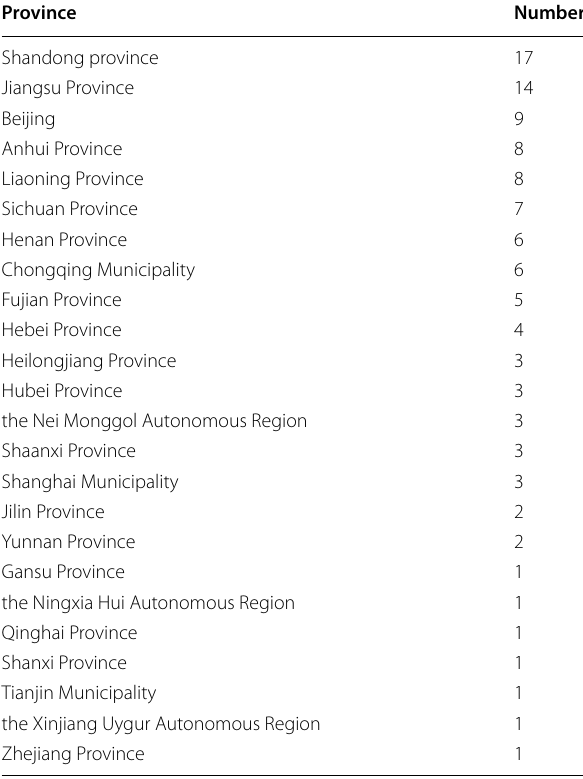
Table 1 Location information of litigation cases